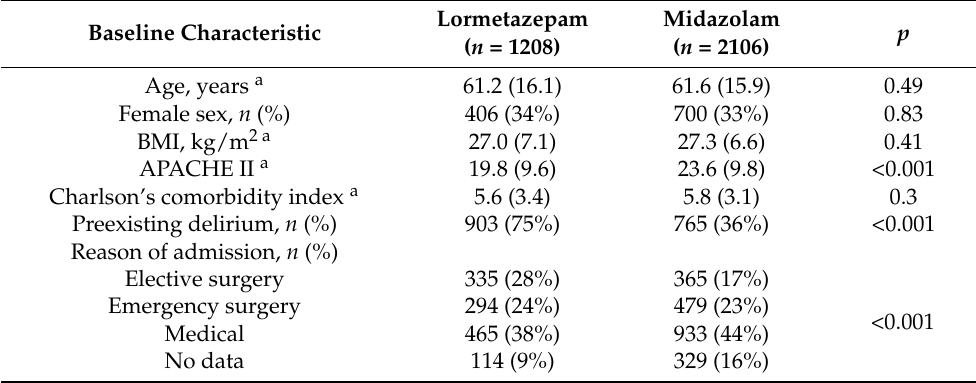
Table 1. Baseline characteristics of patients in the midazolam group and lormetazepam group. Baseline